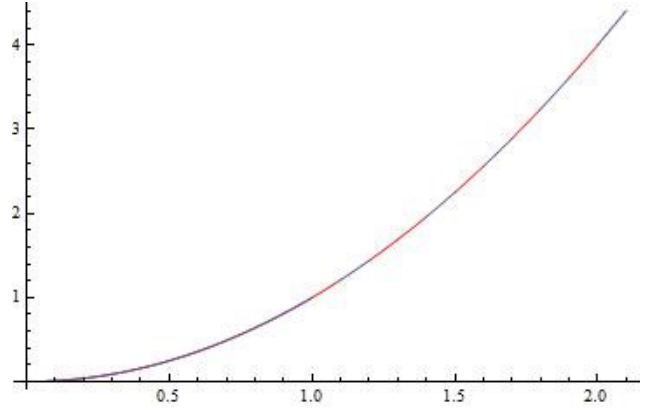
Fig. 6 Graph of the solution using MMIM for the interval [ 0 , 2 ]